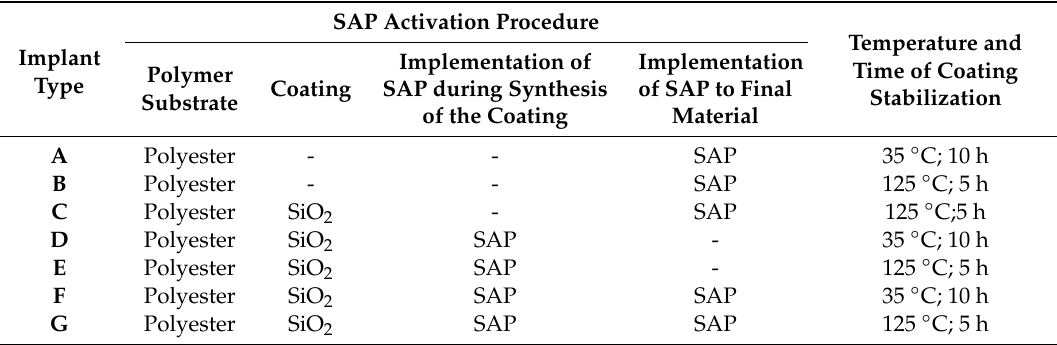
Table 1. Conditions of the preparation of evaluated